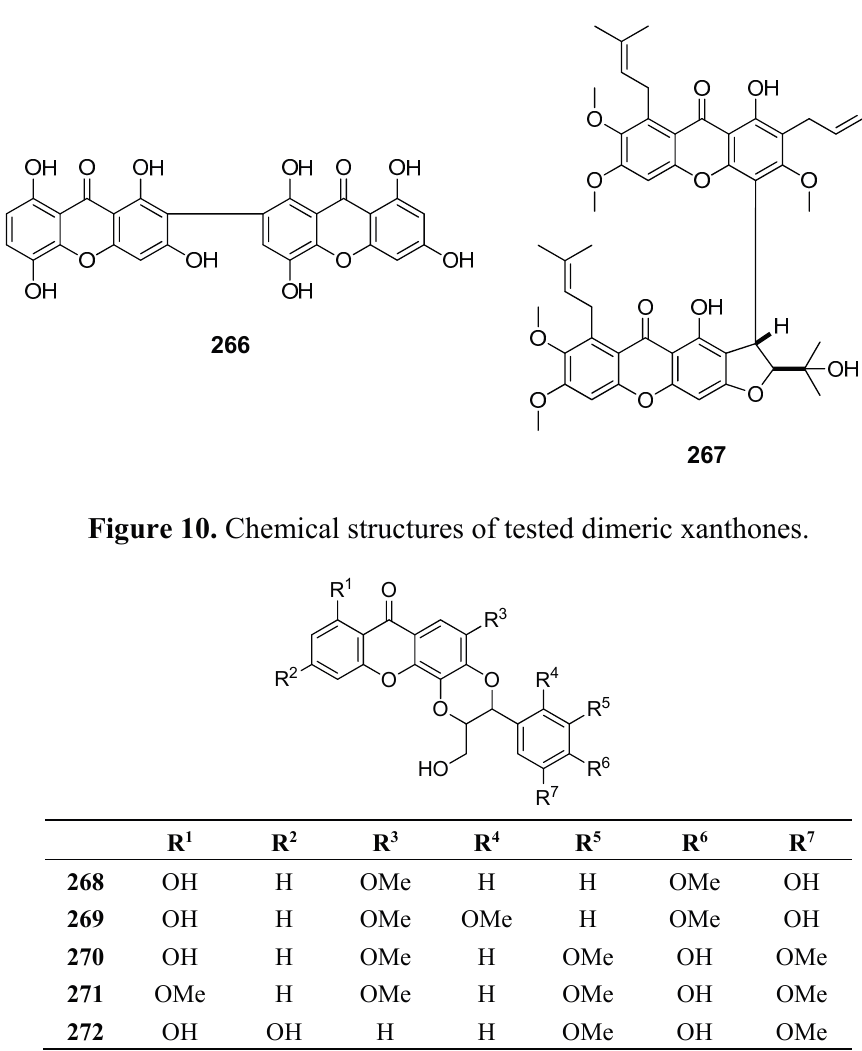
Figure 11. Chemical structures of tested derivatives from